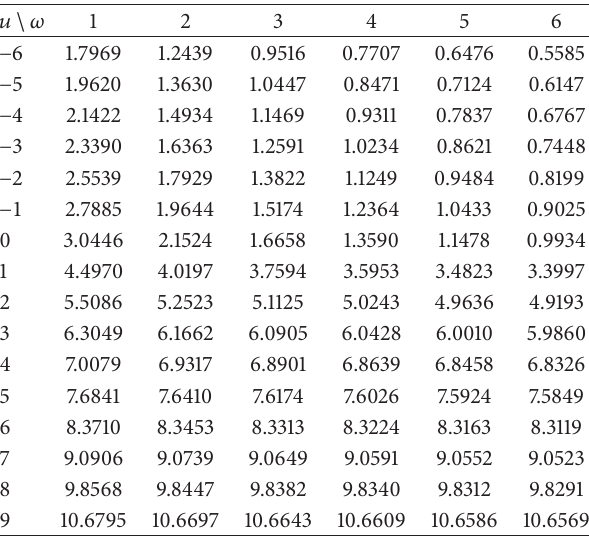
Table 1: Influence of 𝑢 and 𝜔 on 𝑉(𝑢,𝑏) for 𝛿 = 0.1 , 𝑐 = 2 , 𝜆 = 3 , 𝛼 = 1 , and 𝑏 = 10